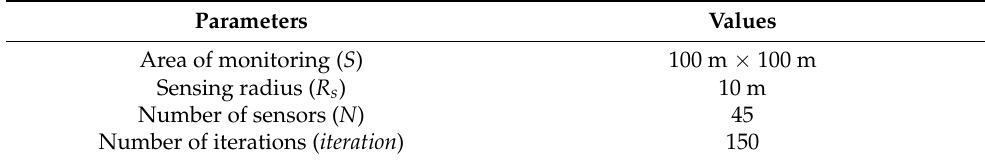
Table 7. Experimental 1 parameter configurations.